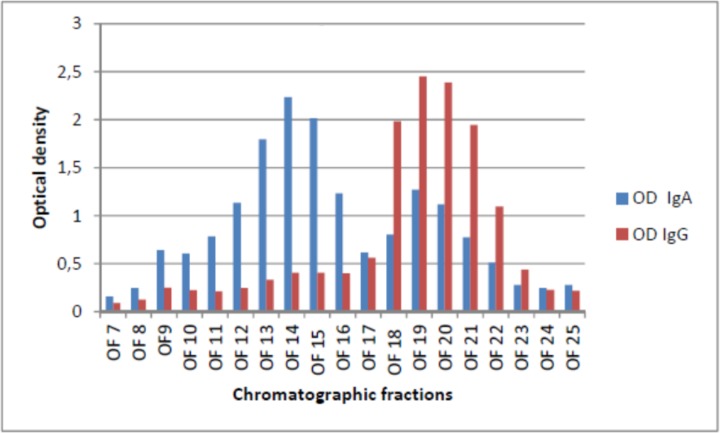
Separation of Ig fractions in OF samples.Dimeric IgA and total monomeric IgA + IgG were separated by means of gel filtration chromatography. Samples were run on a Superdex 200 10/300 GL column (GE Healthcare) under HPLC conditions in an AKTA Purifier apparatus (GE Healthcare). Twenty-six, 0.5-mL fractions were collected and tested by ELISA for IgA and IgG antibody, respectively. This enabled us to detect the fractions corresponding to dimeric IgA (12 to 16) and monomeric IgG+IgA (18 to 21), respectively.